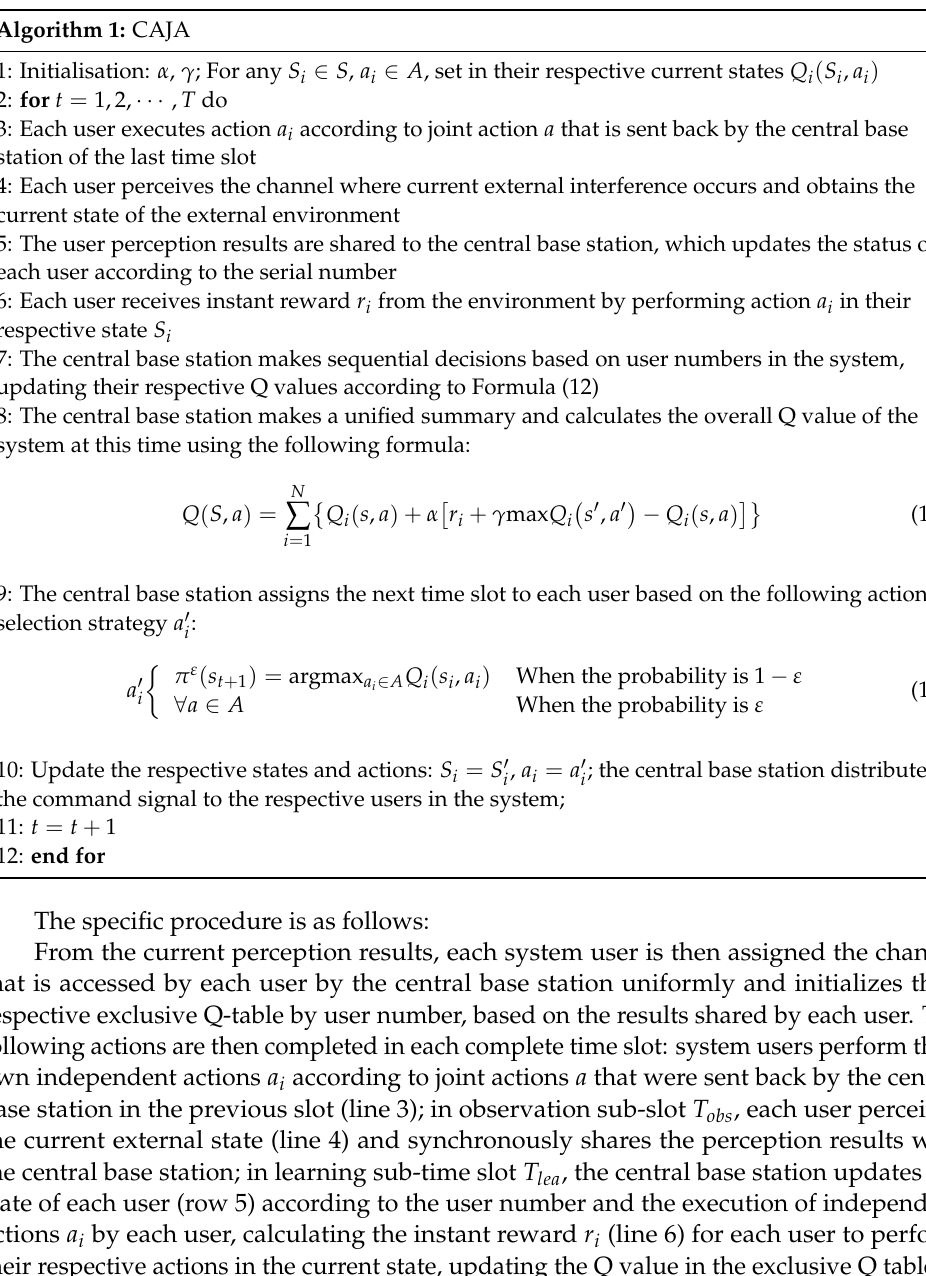
algorithm. The sequential coordination diagram of the central base station according to the Q table of each user can be seen in Figure